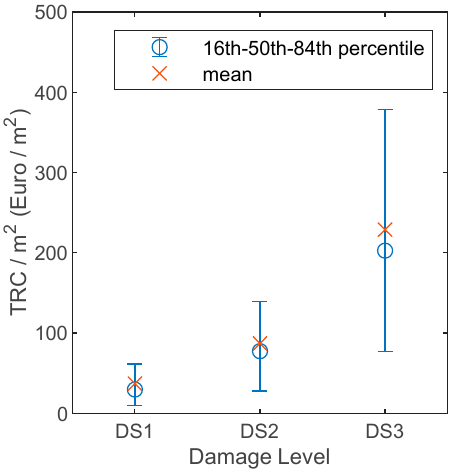
Figure 12. TRC due to infills depending on the maximum attained DS.